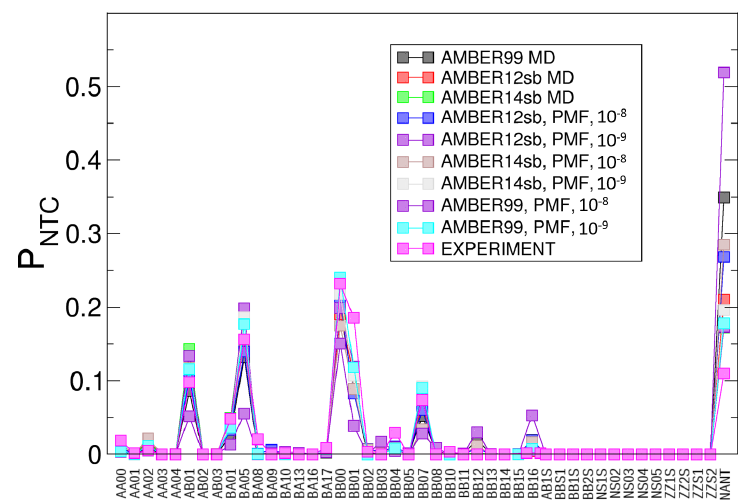
Figure 2. Probability P for the occurrence of a structural class in the 6 different PMF-enriched, 3 MD simulations (AMBER99, AMBER12sb, AMBER14sb, with 2 coupling factors α : 10 − 8 and 10 − 9 ),